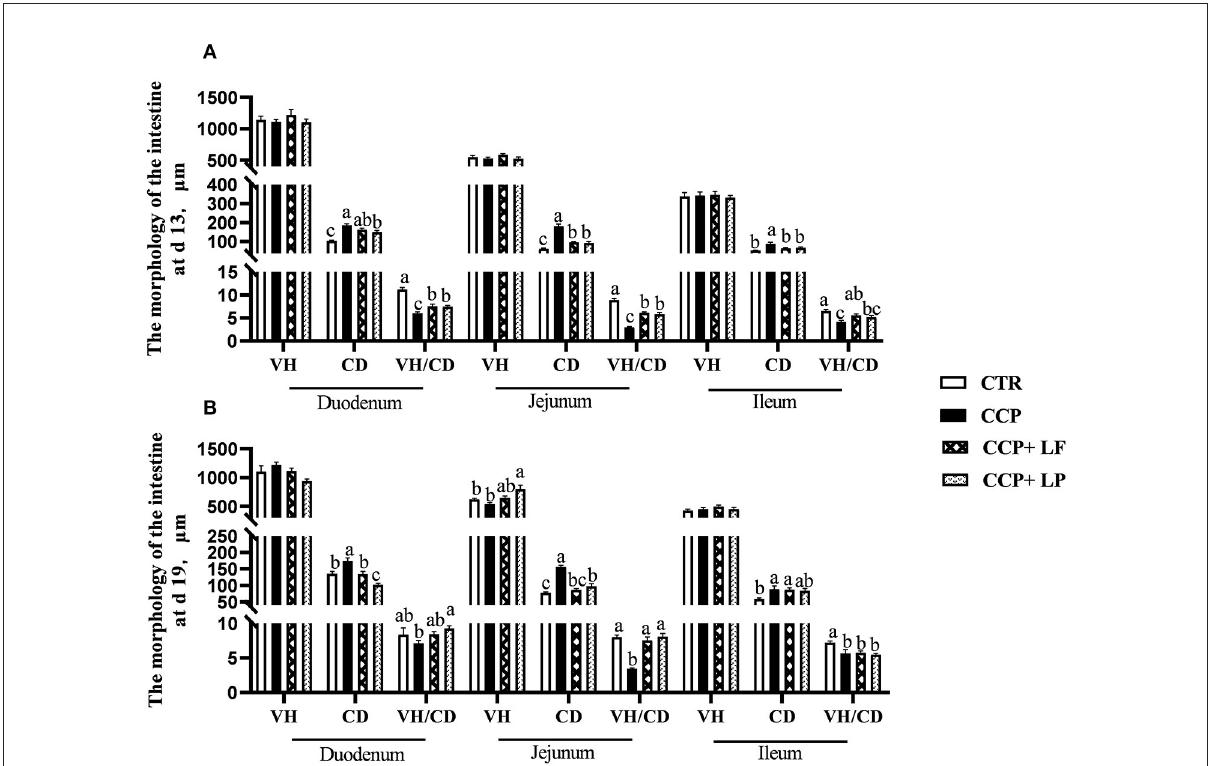
FIGURE2 The intestinal villus height, crypt depth, and the ratio of villus height to crypt depth. (A) the data were collected on day 13, and (B) the data were collected on day 19. Among them, a,b, and c means in the different pillars without common superscripts differ significantly ( P < 0.05). VH, villus height; CD, crypt depth; VH/CD, the ratio of VH to CD. n = 12. Data were presented as mean ± standard error. CTR, the control group; CCP, the group co-infected with coccidia and C. perfringens (CCP), CCP + LF and CCP + LP denote the groups fed Lactobacillus fermentum - and Lactobacillus paracasei -supplemented diets with CCP